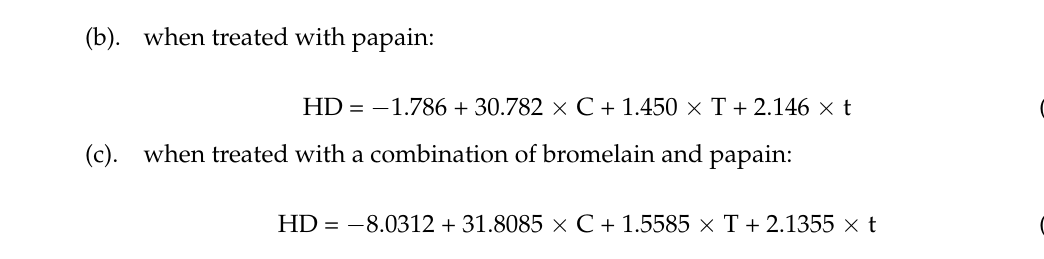
( b ) Figure 7. Peak area of HPLC chromatogram of wheat bran samples gliadin extract after incubation of 4 h at 45 °C: ( a ) ω -gliadins; ( b ) α -gliadins (BC, control bran sample; BB, bran treated with brome- lain; BP, bran treated with papain, BM, bran treated with a combination of bromelain and papain). α -Gliadins have the highest immunoreactivity; therefore, their changes are most rel- evant. The highest peak at 17.5 min is shown in Figure 7b. HPLC results showed that α - gliadin content decreased significantly after enzymatic hydrolysis. Comparing the peak areas of the gliadin peaks between the control bran sample and the samples treated with different enzymes, it can be stated that the proteolytic effect of the plant enzymes was